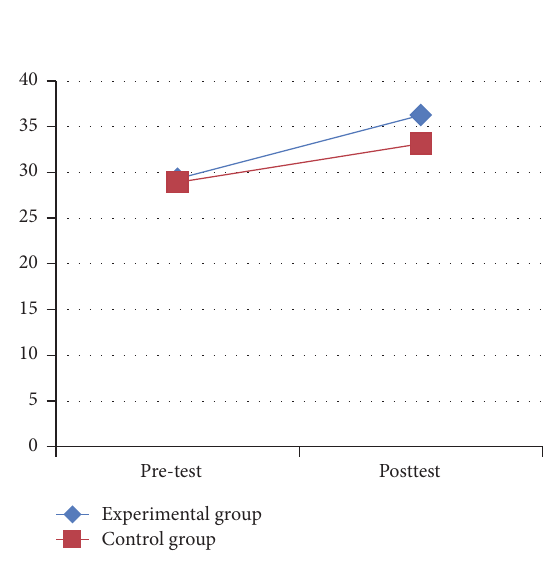
Figure 5: Academic achievement